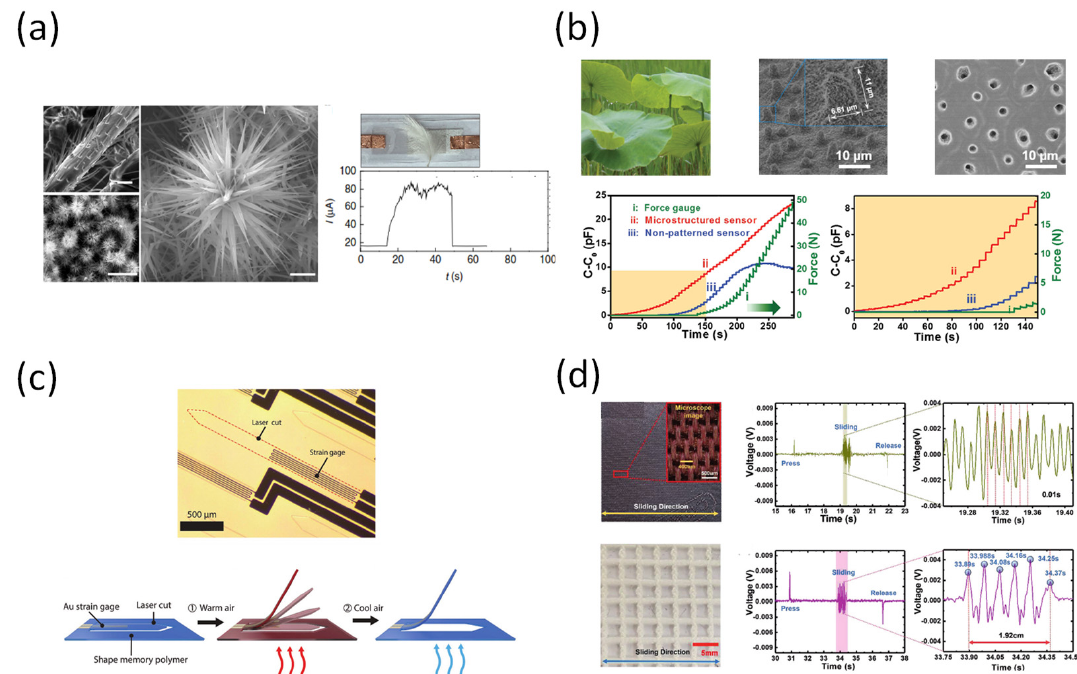
Figure 11. ( a ) A tactile sensor inspired by bristles or tactile hairs [159]. ( b ) Artificial intelligence based on the structure of the lotus leaf [162]. ( c ) Multimodal Electronic Whiskers [163] . ( d ) Tactile sensing system mimicking human tactile [164] .